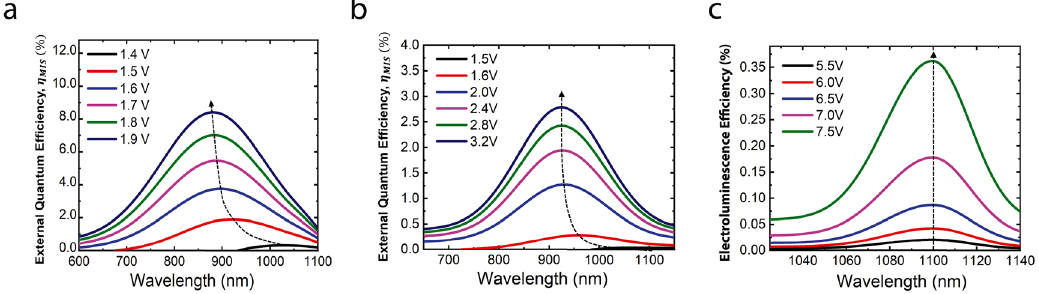
Figure4: Theexternalquantumefficiency, η MIS ,of(a) N d =1.0 × 10 20 cm − 3 ,(b) N d =3.6 × 10 18 cm − 3 andtheelectroluminescenceef fi ciencyof(c) N d = 1.9 × 10 16 cm − 3 from FEM models. η MIS can be interpreted to be proportional to the emitted photon fl